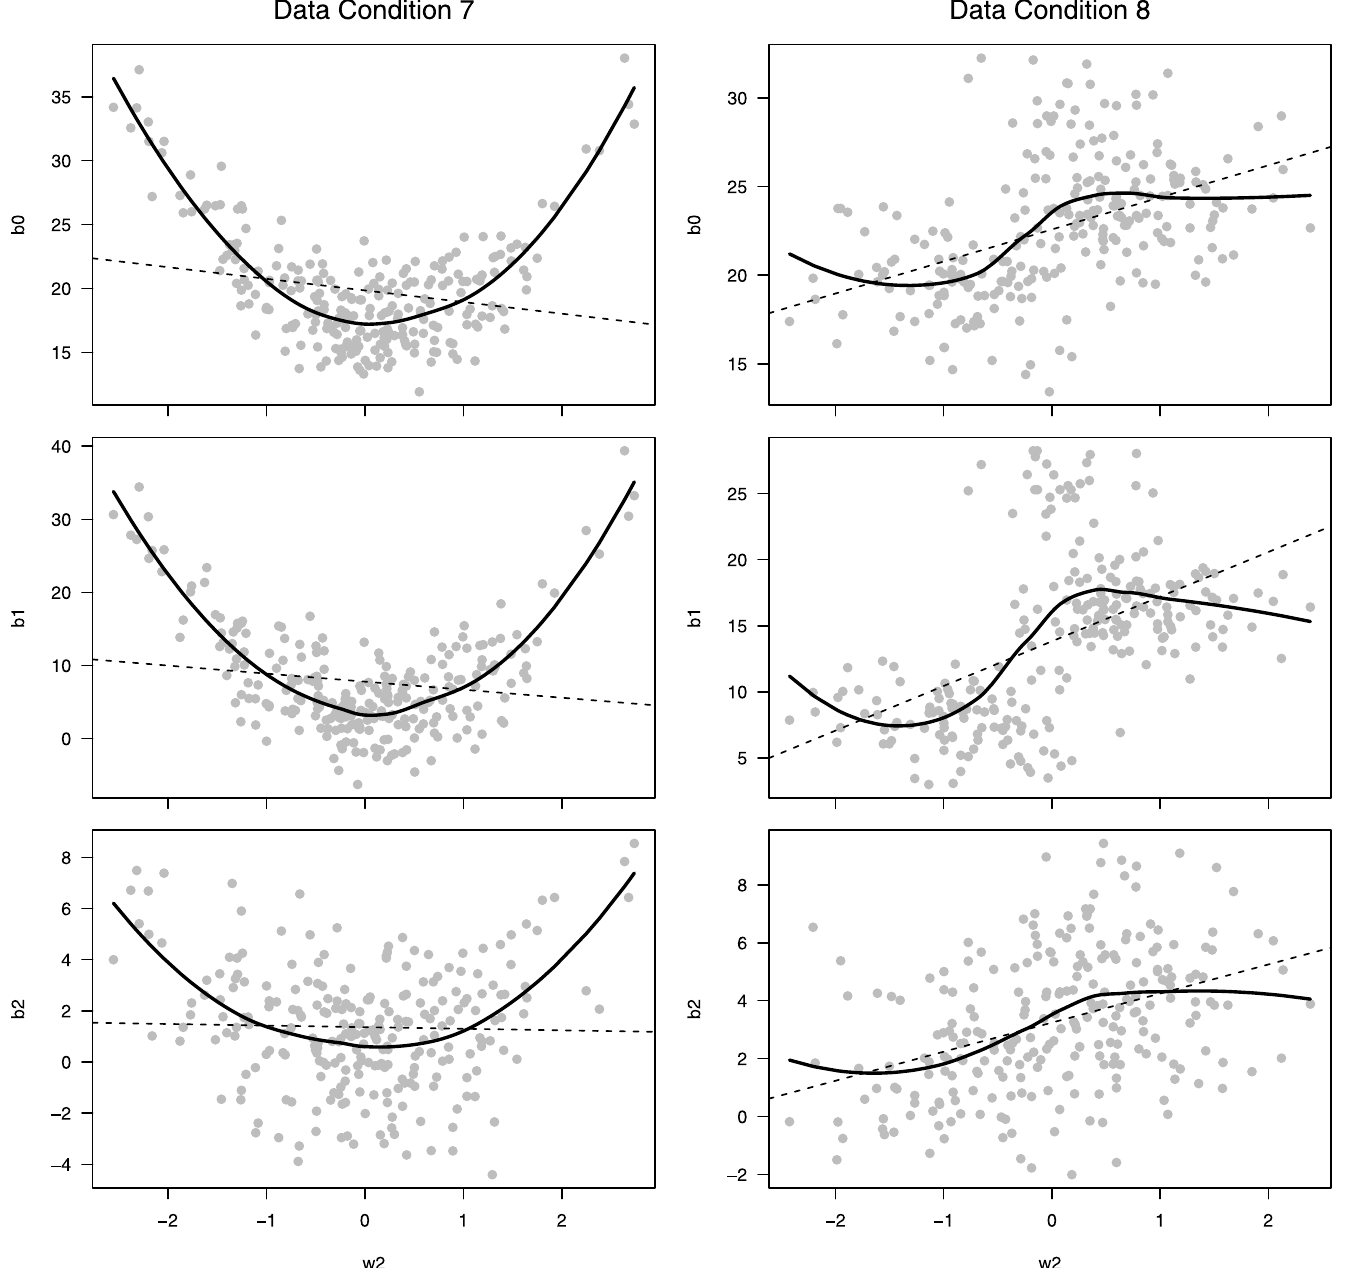
Fig 6. Simulated quantitative exposure, w 2 (x-axis) and growth parameters from individual quadratic model fits (y-axes) for one data set under data condition 7 (quadratic growth with a deterministic, quadratic relationship between growth parameters and exposure) and data condition 8 (quadratic growth with a stochastic, non-monotonic relationship between growth pattern probabilities and exposure). Dashed line is a least squares line and the thick line is a smooth loess curve.